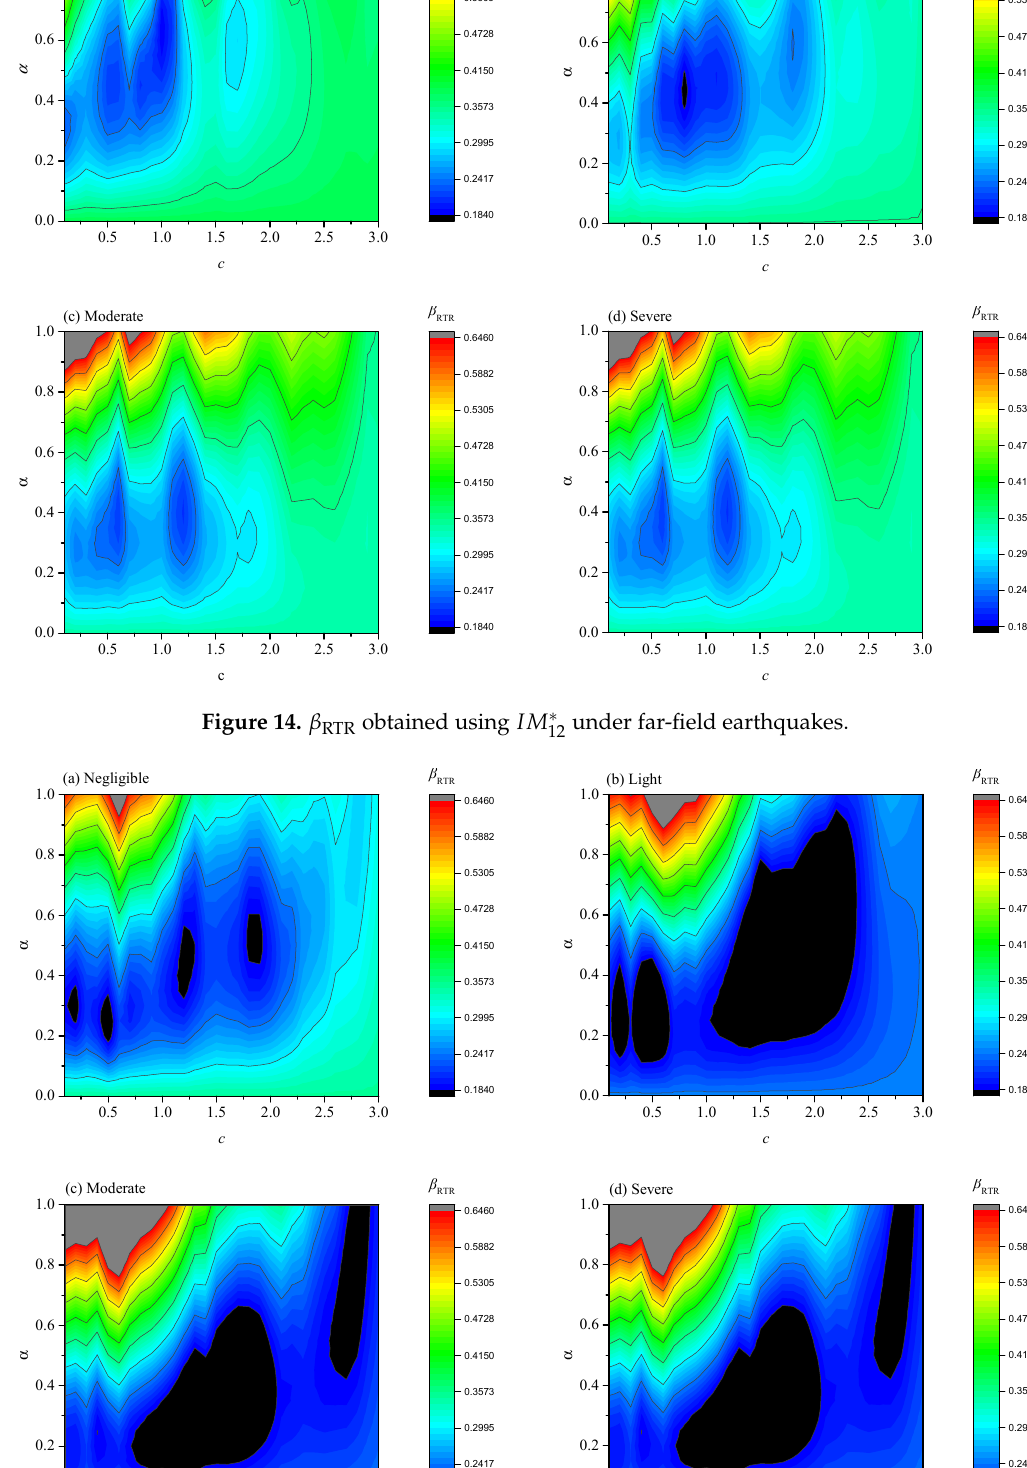
Figure 15. β RTR obtained using IM ∗